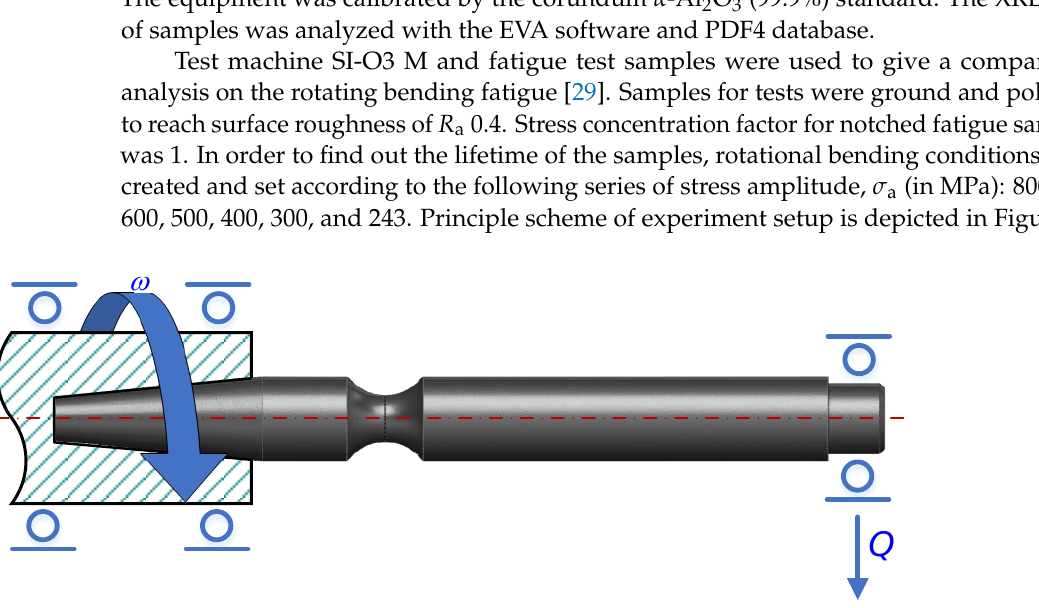
Figure 2. Principal scheme of cantilever-type rotating bending fatigue test experimental setup (rotation speed ω = 3000 rpm, a bending load range Q 800, 700, 600, 500, 400, 300 and 243 N).